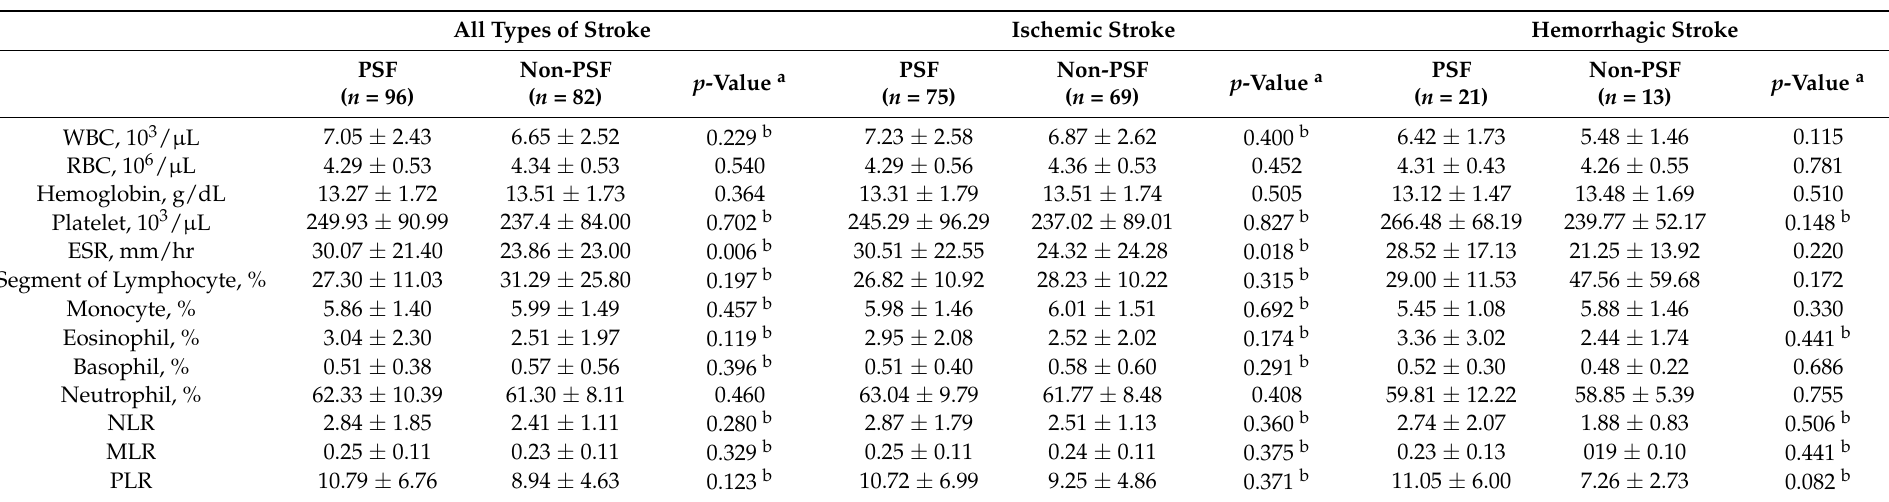
Table 4. Comparison of hematologic data between the PSF and non-PSF groups.